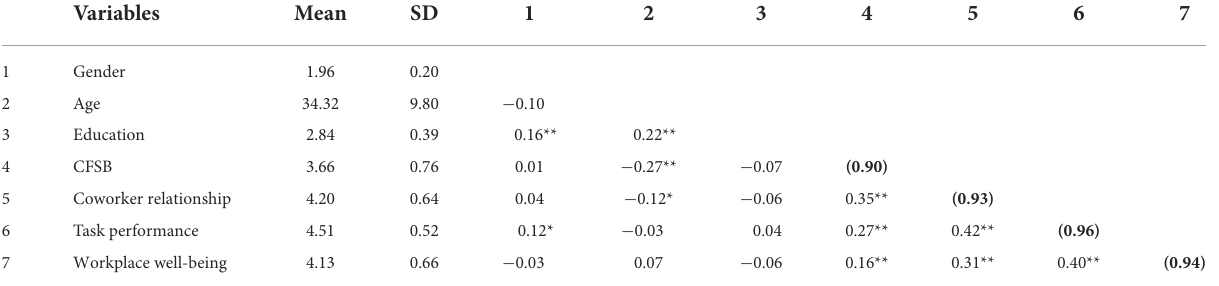
TABLE 2 Means, standard deviations, reliabilities, and correlations among study variables.